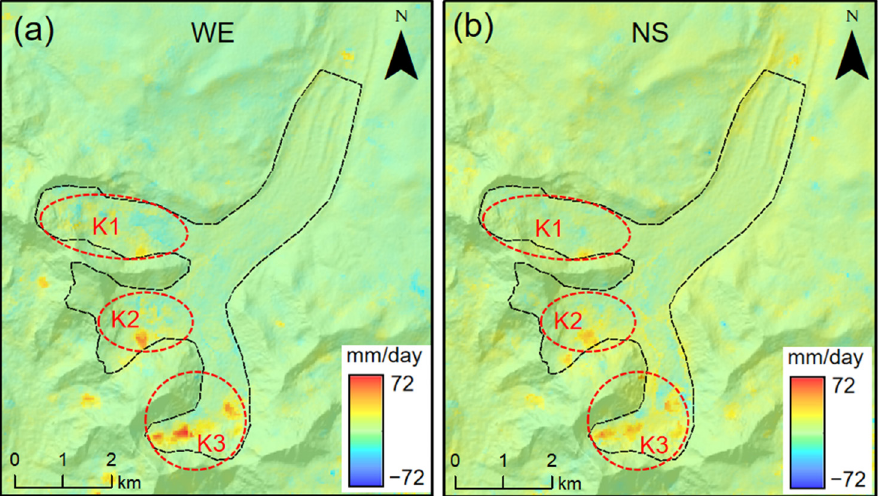
Figure 8. Glacial flow rate difference before and after fusion in the study area: ( a ) west–east difference of deformation rate; ( b ) north–south difference of deformation rate.